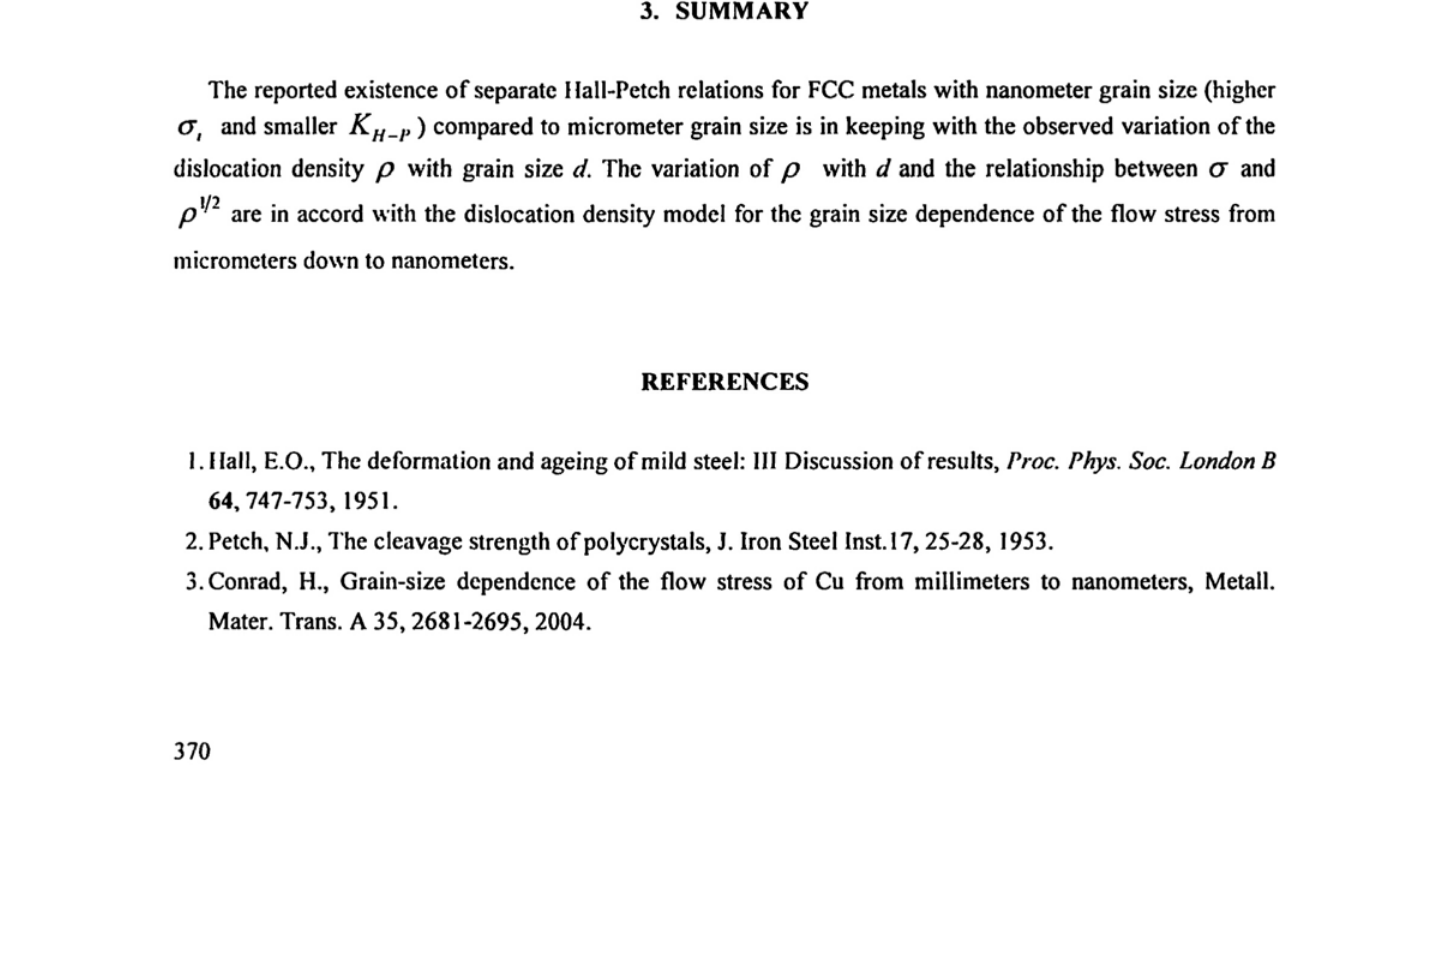
Fig. 5: Log σ vs logi/ for Cu. Included are the variation of dislocation cell size l elastic interaction spacing l